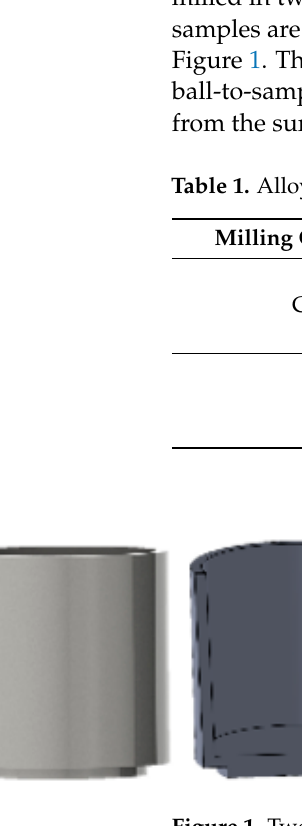
Figure 1. Two types of milling containers: ( a ) cylinder and ( b ) barrel.